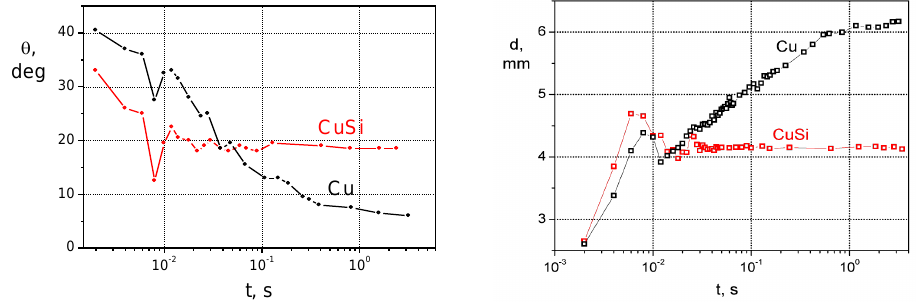
Figure 9. Visible contact angle ( left ) and drop base diameter ( right ) as a function of time plotted on a logarithmic scale for Cu and Cu presaturated in Si on a (001) Si surface at 1100 °C. Dispensed drop technique [8].